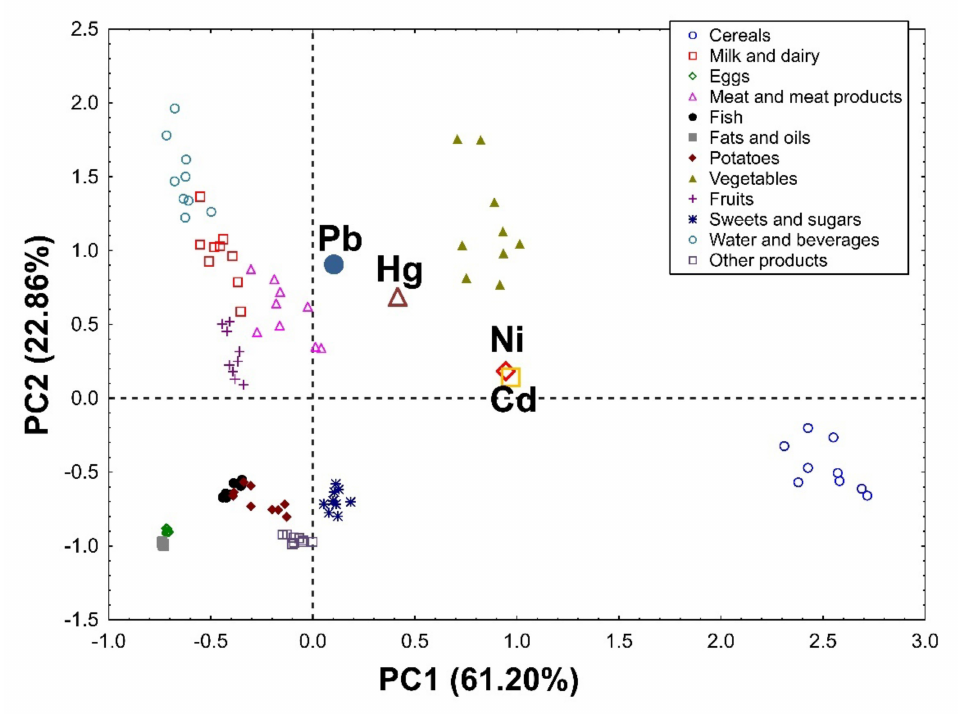
Figure 1. PCA biplot showing loadings (for heavy metals) and scores (for products) of the first two principal components of PCA in the group of women, explaining together 84.06% of the variability in the obtained dataset (61.20% and 22.86% in PC1 and PC2, respectively).